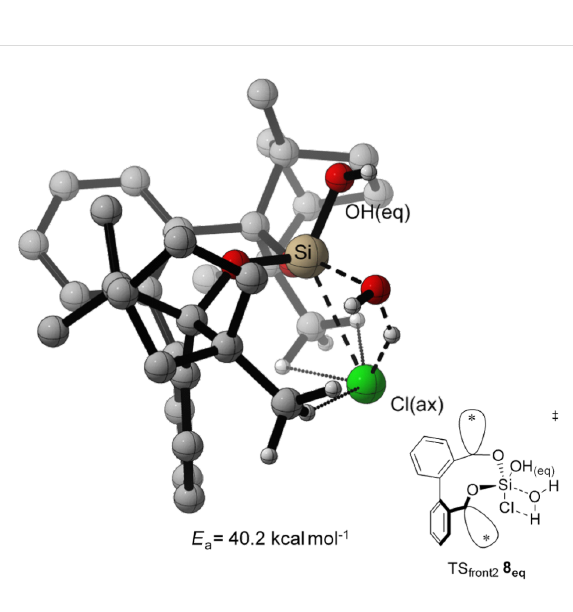
Figure 11: Transition state leading to 9 following front2 attack ( E a = 40.2 kcal mol − 1 , Figure 5, Table 3, entry 5). Breaking and forming bonds in dashed lines, additional C–H-interactions with dotted lines (M06-2X-D3/6-311++G(d,p)(PCM=THF)//B3LYP-D3BJ/6-31G(d) at 298